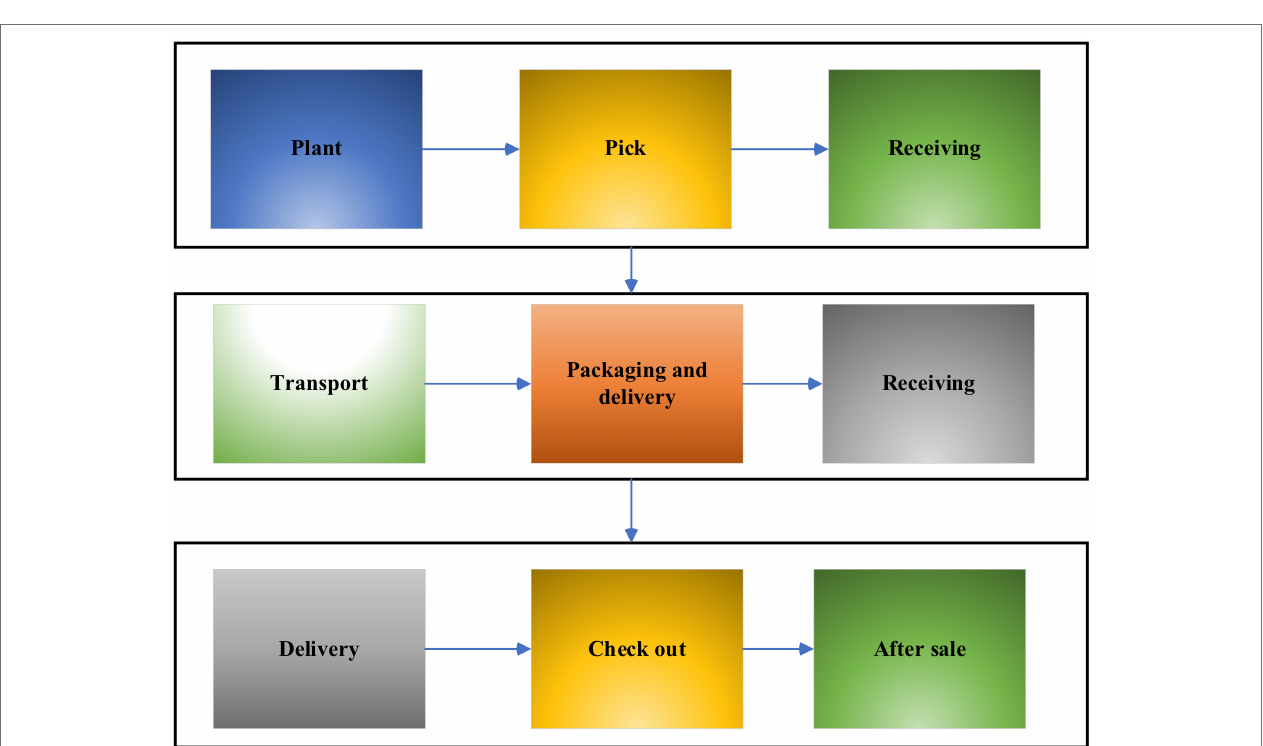
FIGURE 16 | The process of food production from “production end to consumption end.”